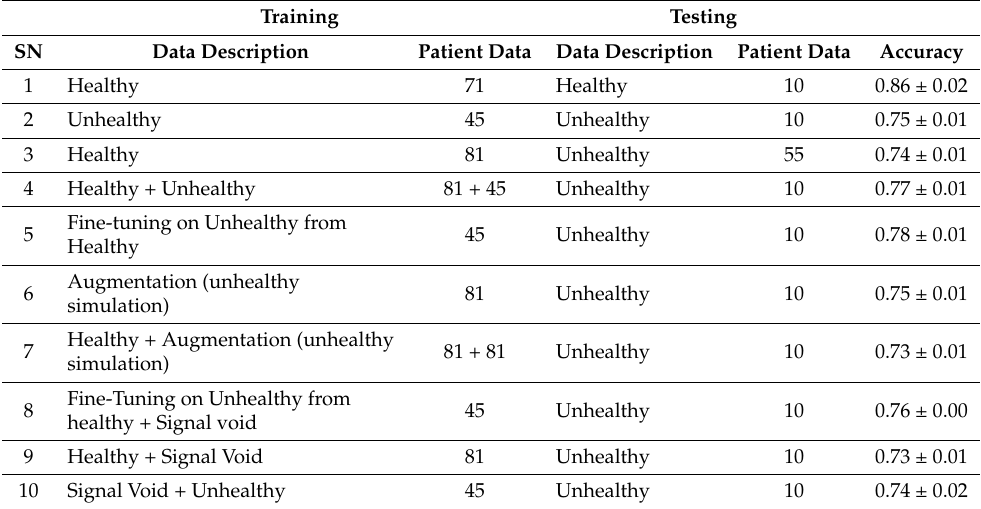
Table 3. fMRI network classification for healthy and unhealthy data (patient counted as whole represent seven fMRI network images in each